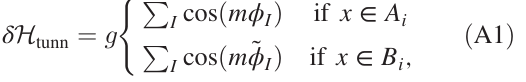
corresponds to i − 1